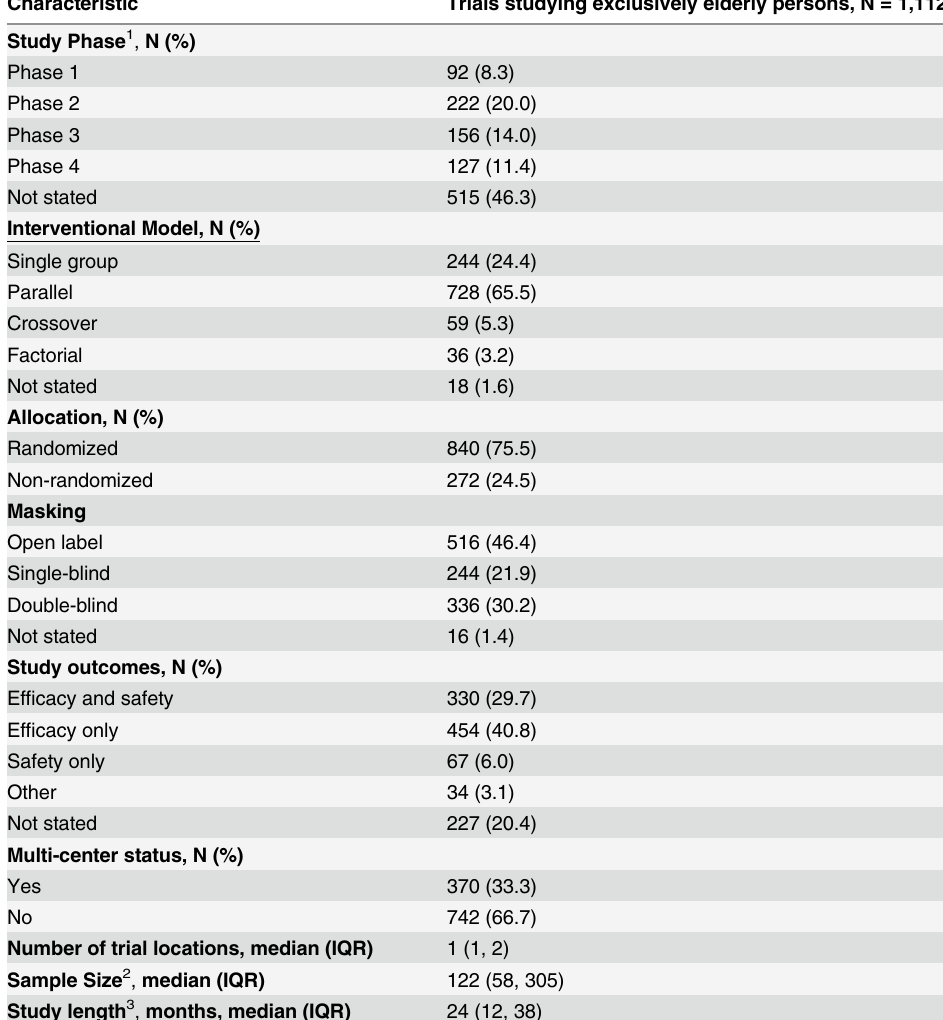
Table 2. Study design characteristics of registered interventional trials studying exclusively elderly